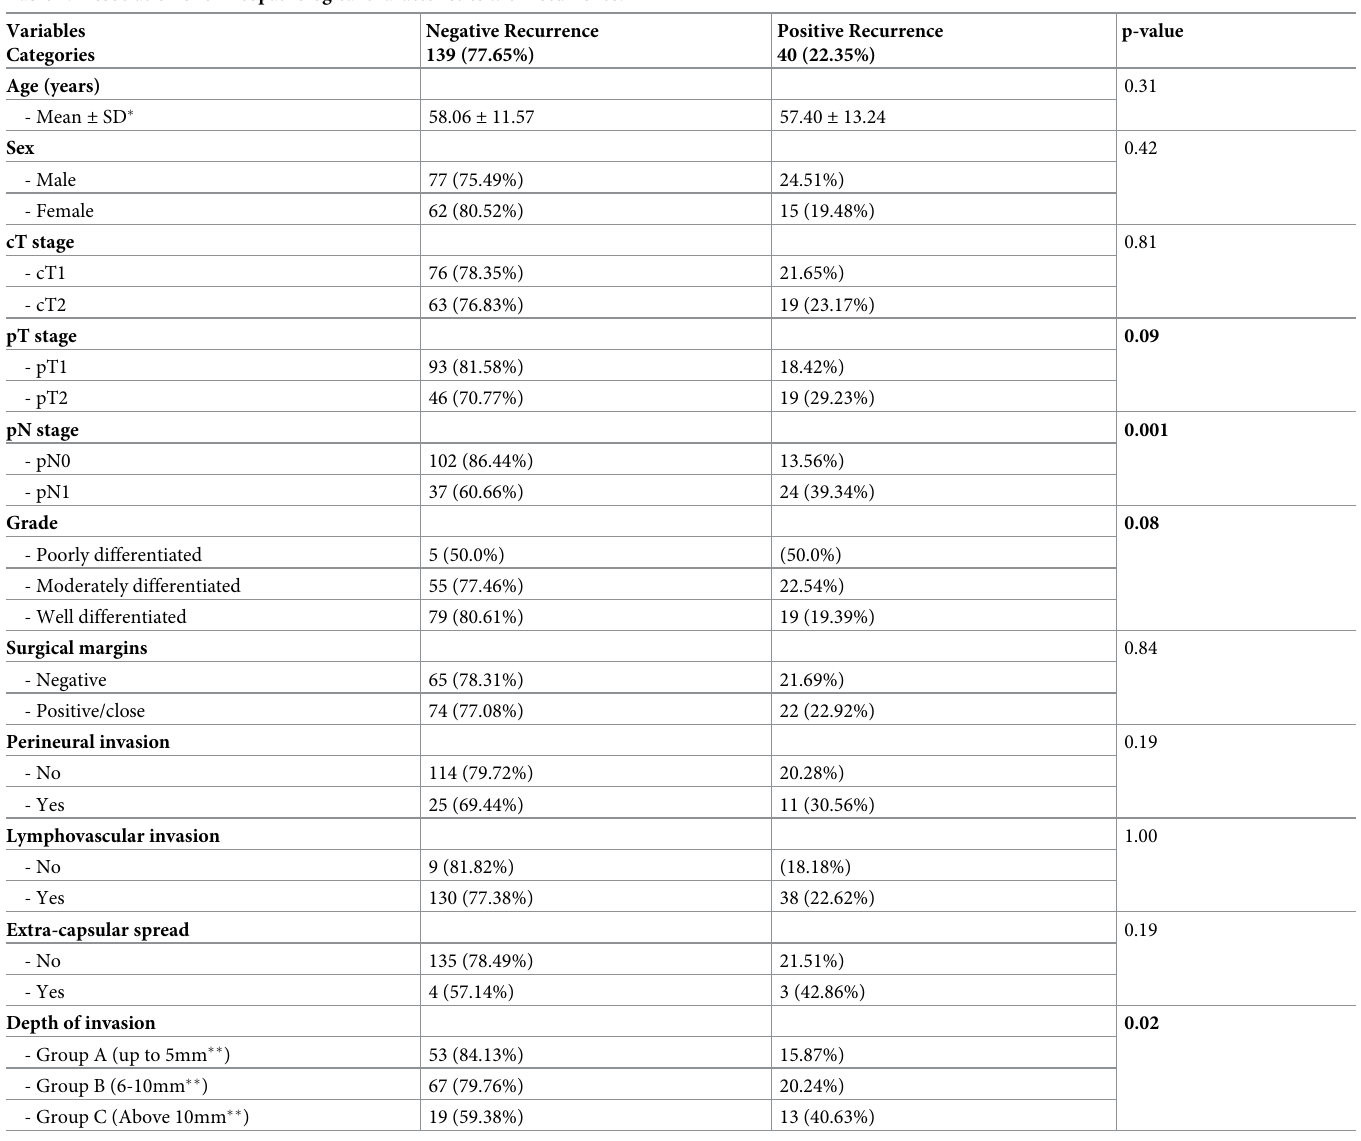
Table 2. Association of clinicopathological characteristics with